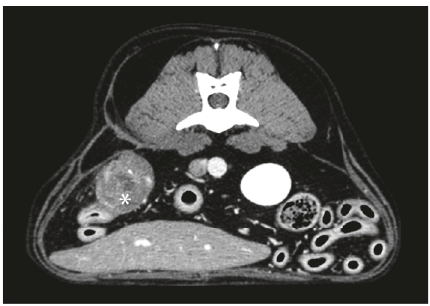
Figure 4: Transverse postcontrast computed tomographic image approximately three months following surgical debridement of a gossypiboma, displayed in a soft tissue window. The soft tissue attenuating mass within the right caudal abdomen ( ∗ ) has markedly decreasedinsizeandislesscontrast-enhancingthanpriortosurgery with persistence of a non-contrast-enhancing hypoattenuating cen- ter. The previously seen large, cystic subcutaneous mass is no longer